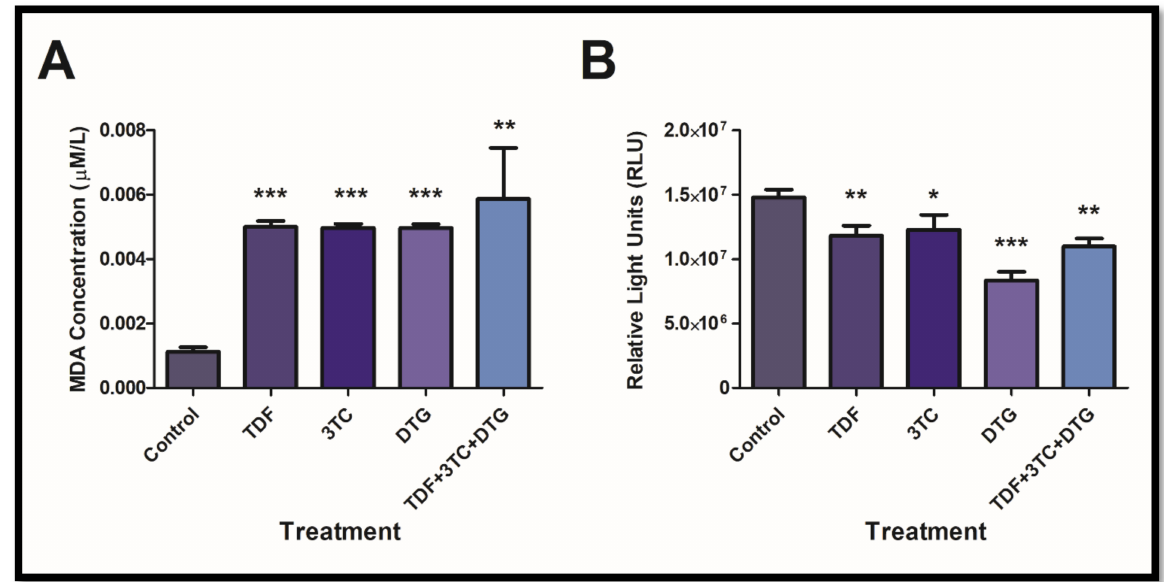
Figure 4. ARVs increased MDA concentration ( A ) and decreased ATP concentration ( B ). Considerable increases in MDA were observed for all ARV treatments ( A ), with significant decreases in ATP. * p < 0.05, ** p < 0.005, *** p < 0.0001 relative to